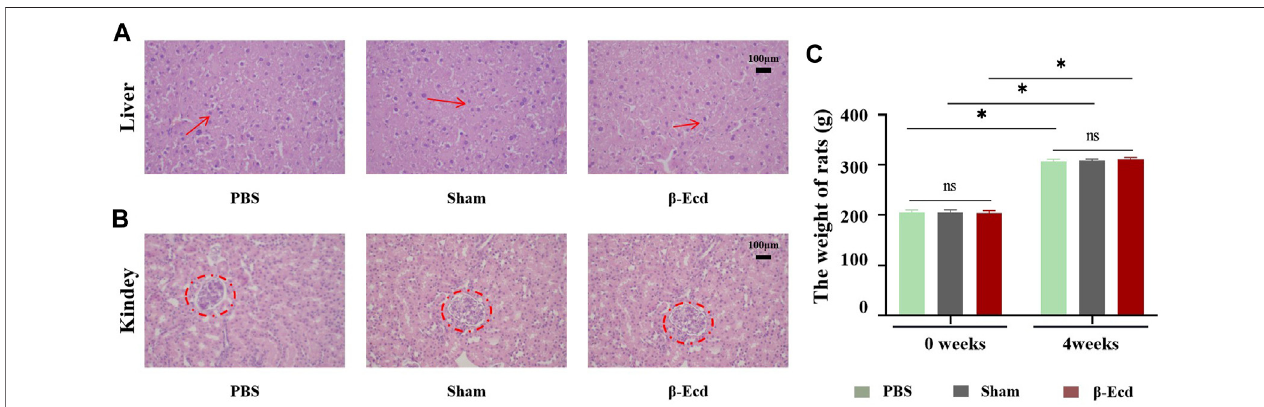
FIGURE 5 | Effect of β -ecdysterone on tissue architecture of rats 4 weeks after surgery was compared with that before surgery. (A) Depicts the hematoxylin and eosinstainedsectionofliverfromcontrolrat,shamratand rattreatedwith92 mg/kg β -ecdysteroneshowingnosignsofhepatotoxicity(showninarrow). (B) Depictsthe hematoxylin and eosin stained section of kidney from control rat, sham rat and rat treated with 92 mg/kg β -ecdysterone showing no signs of nephrotoxicity (shown in circle). (C) 4 weeks after surgery, the weight of rats in different groups increased respectly, and β -ecdysterone showing no signs of weight loss. *p < 0.05 and NS, no signi fi